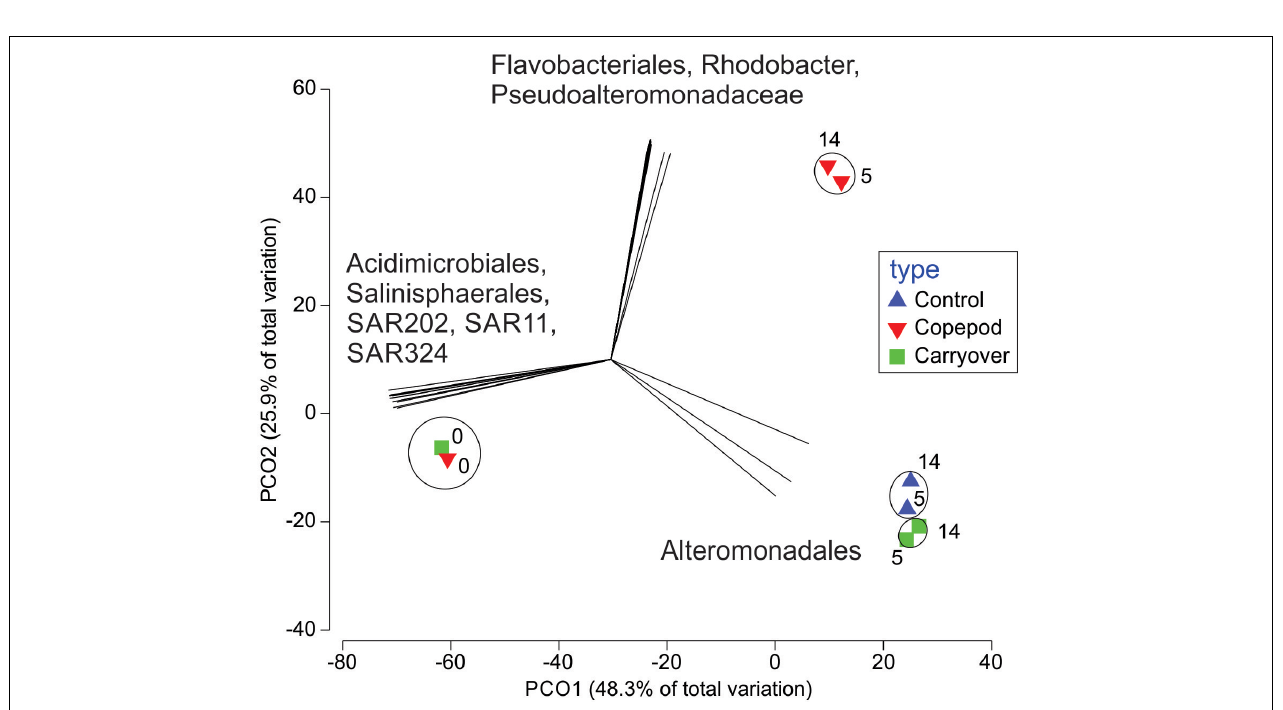
FIGURE 7 | Principal coordinates analysis assessing the change in bacterioplankton community over the 14-day incubation (numbers represent days of the incubation) in the microbial remineralization experiment. The comparison is constructed using a Bray–Curtis similarity matrix of the ASVs relative contribution per sample. A SIMPROF cluster analysis show statistically similar communities ( p < 0.05; black circles), while a Pearson correlation indicates which ASVs contributed to observed patterns in abundance (denoted as vectors; R > 0.95).